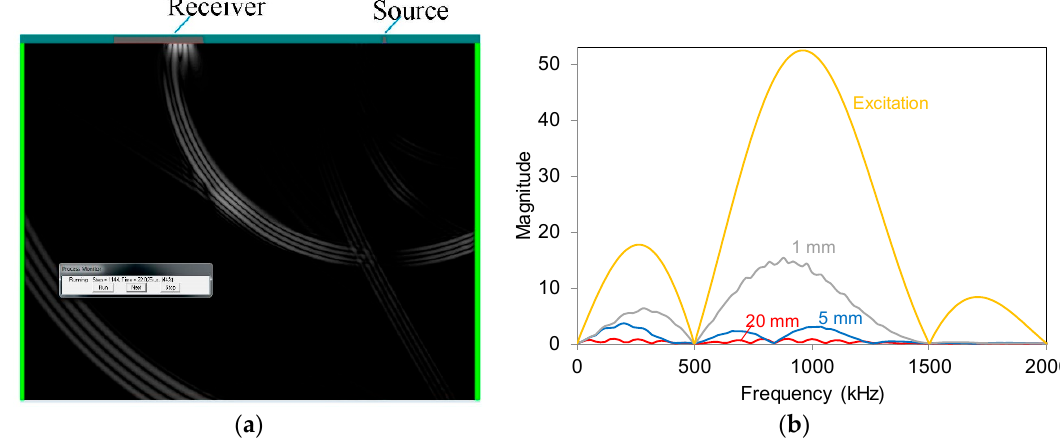
Figure 3. ( a ) Snapshot of displacement field corresponding to 22 µs after excitation (frequency at 1 MHz). The source is set on the surface; ( b ) Fast Fourier Transforms (FFT) functions of the waveforms received by different size sensors.